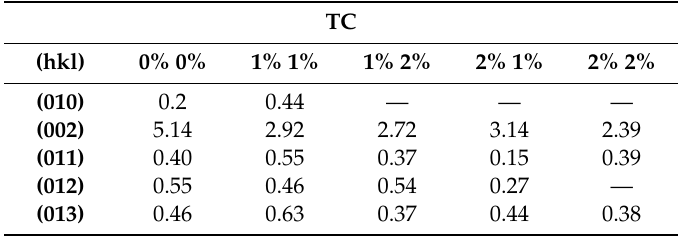
Table 2. Values of the texture coe ffi cient (TC) of undoped and (Co%, Mn%) co-doped ZnO nanocrystalline